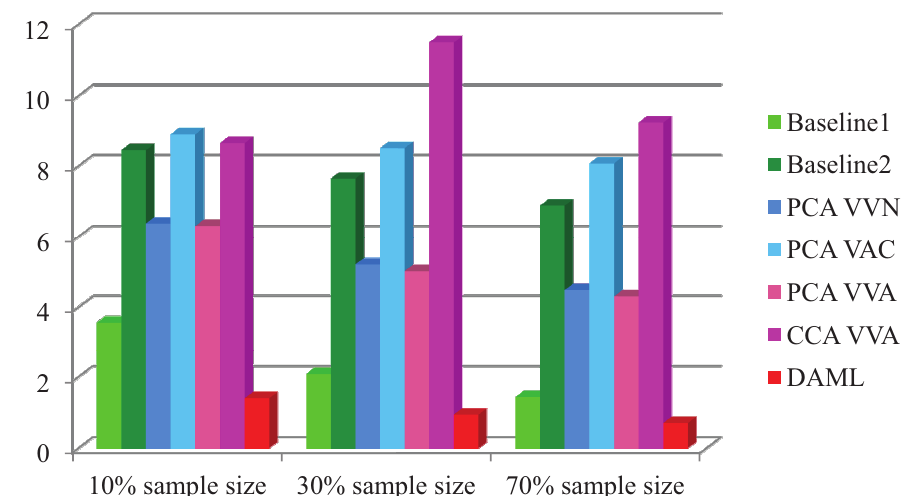
Figure 7. Stabilities of detection under different training sample size